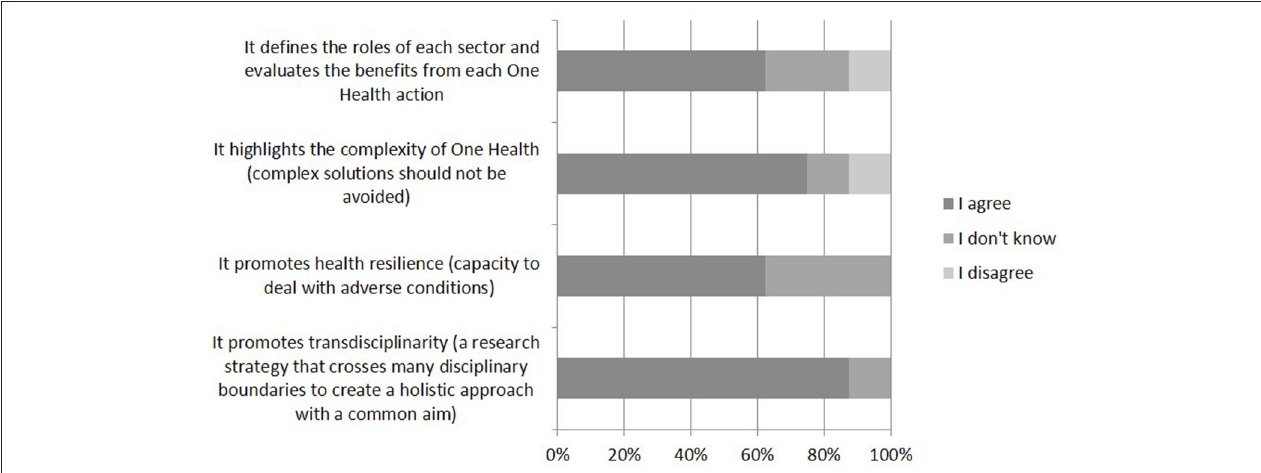
FIGURE 5 | Answers from eight stakeholders and external partners to the online question, “which of the following do you see as benefits of the One Health